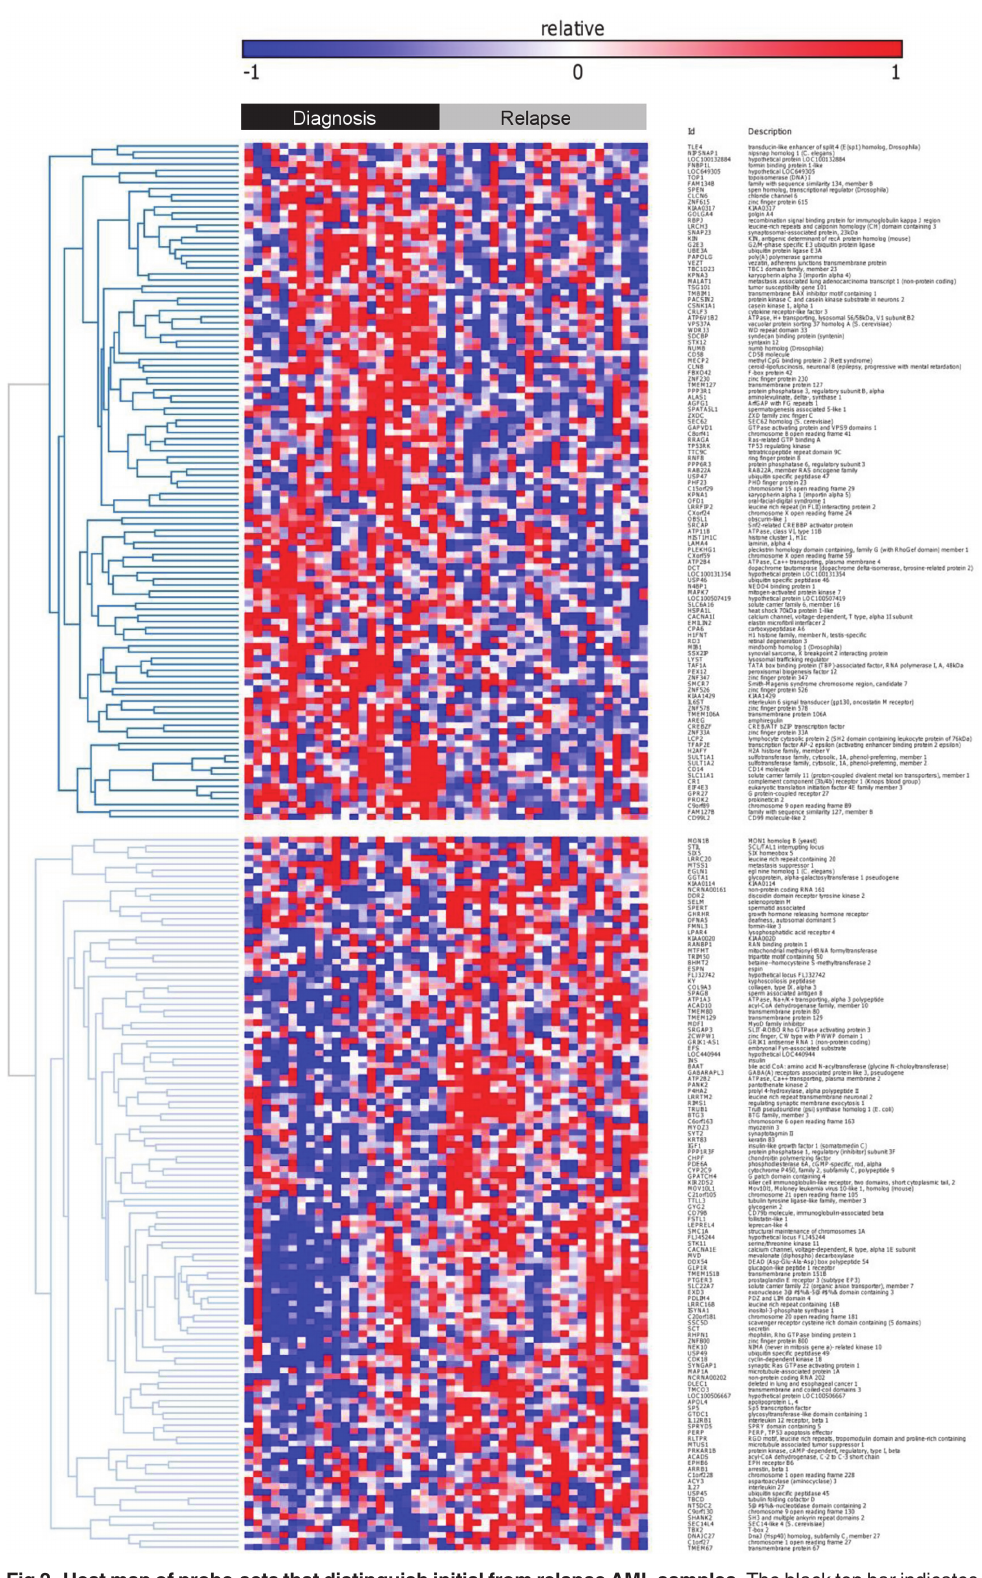
Fig 2. Heat map of probe-sets that distinguish initial from relapse AML samples. The black top bar indicates initial AML samples and the top gray bar represents relapse AML samples. doi:10.1371/journal.pone.0121730.g002 PLOS ONE | DOI:10.1371/journal.pone.0121730 April 7,